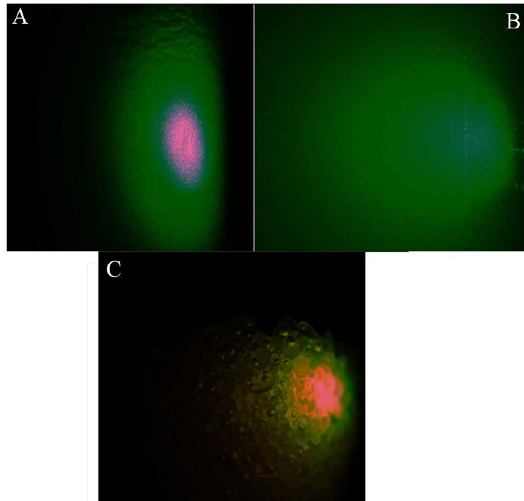
Figure 8. Fluorescence images of (A) 10 w/v % aqueous suspension of titanium oxide particles, (B) 10 w/v % aqueous suspension of glass microspheres and (C) 10 w/v % aqueous suspension of PVA / PVAc- Rhodamine microspheres.